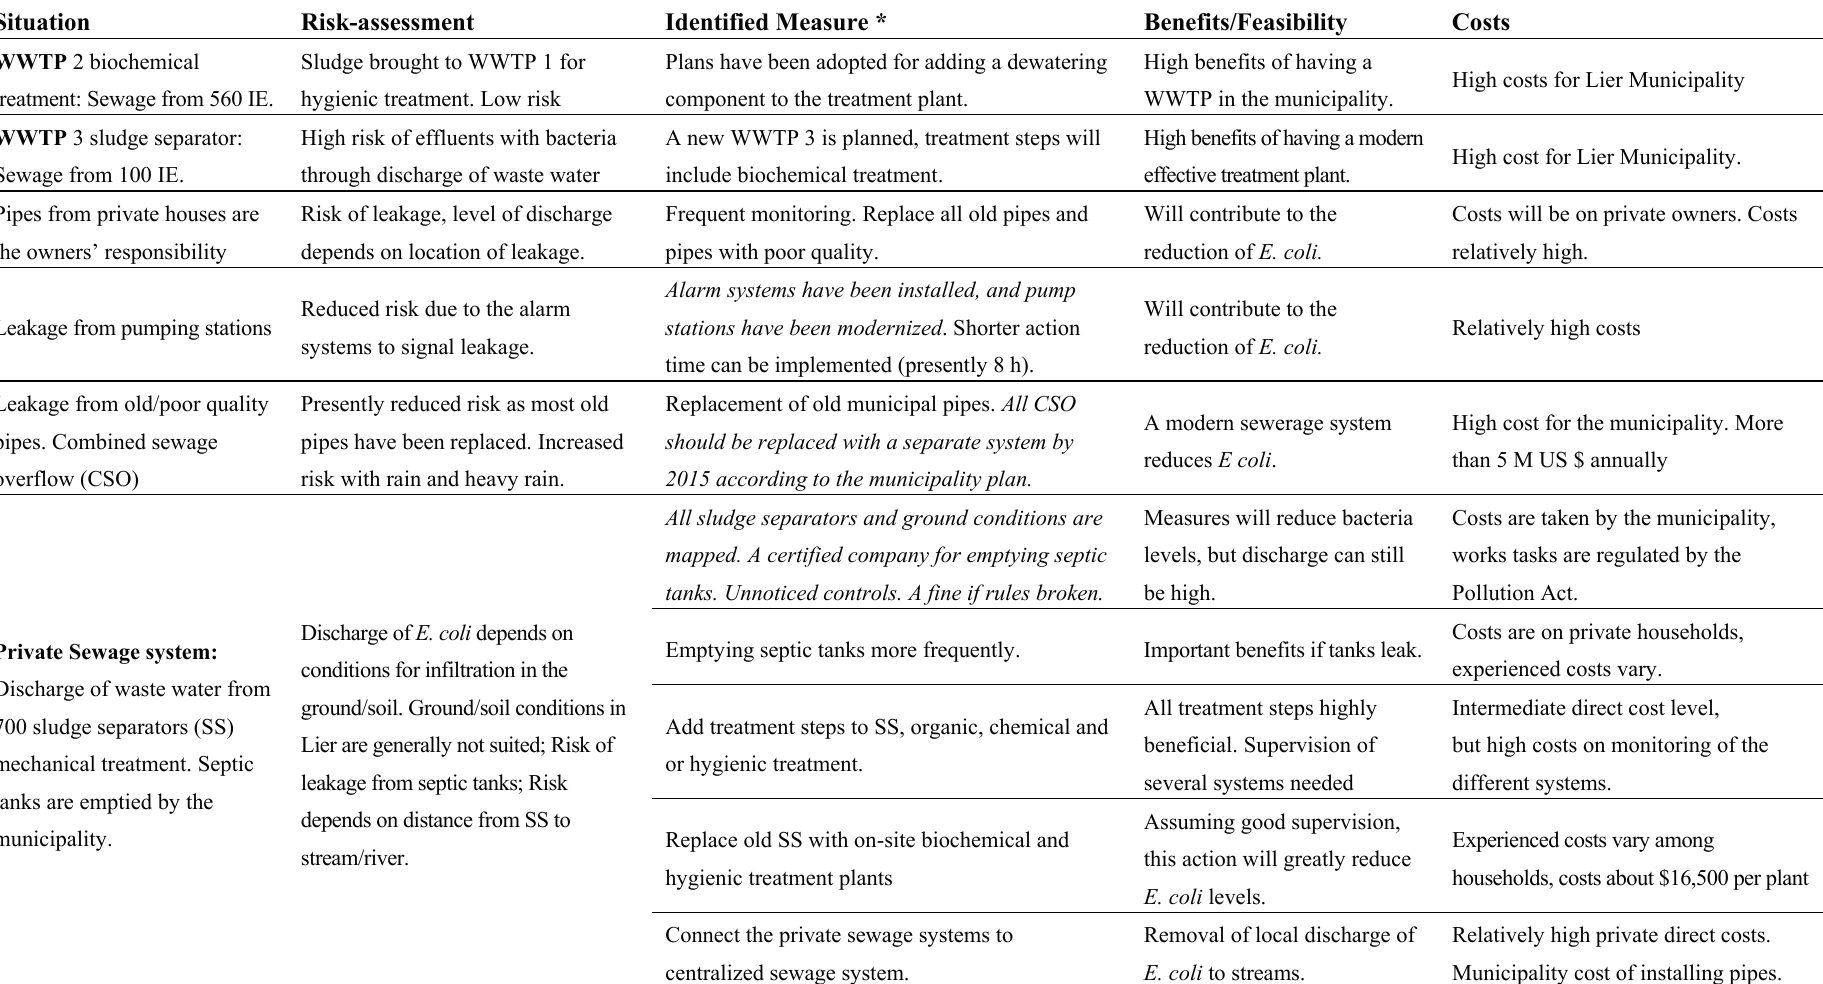
Table 5. Identified risks and measures for pollution